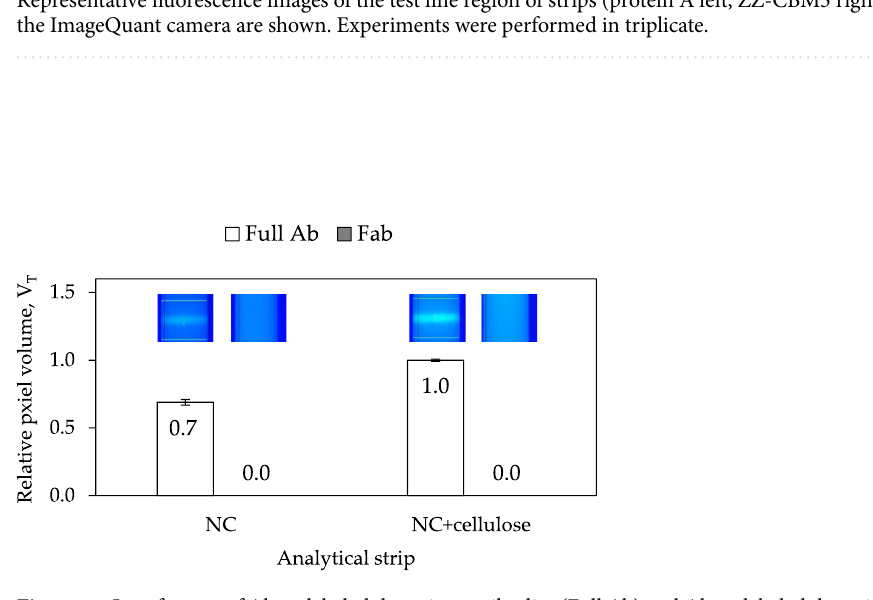
Figure 5. Interference of Alexa-labeled detection antibodies (Full Ab) and Alexa-labeled detection antibody fragments (Fab) with capture antibodies anchored with ZZ-CBM3 fusions on test lines of LFA. Experiments were performed using analytical strips of NC and of NC with a coat of cellulose on the test line. The pixel volume of test lines, V T , was normalized relatively to the highest pixel volume obtained. The inset fluorescence images of the test line region were obtained by the ImageQuant camera. Experiments were performed in